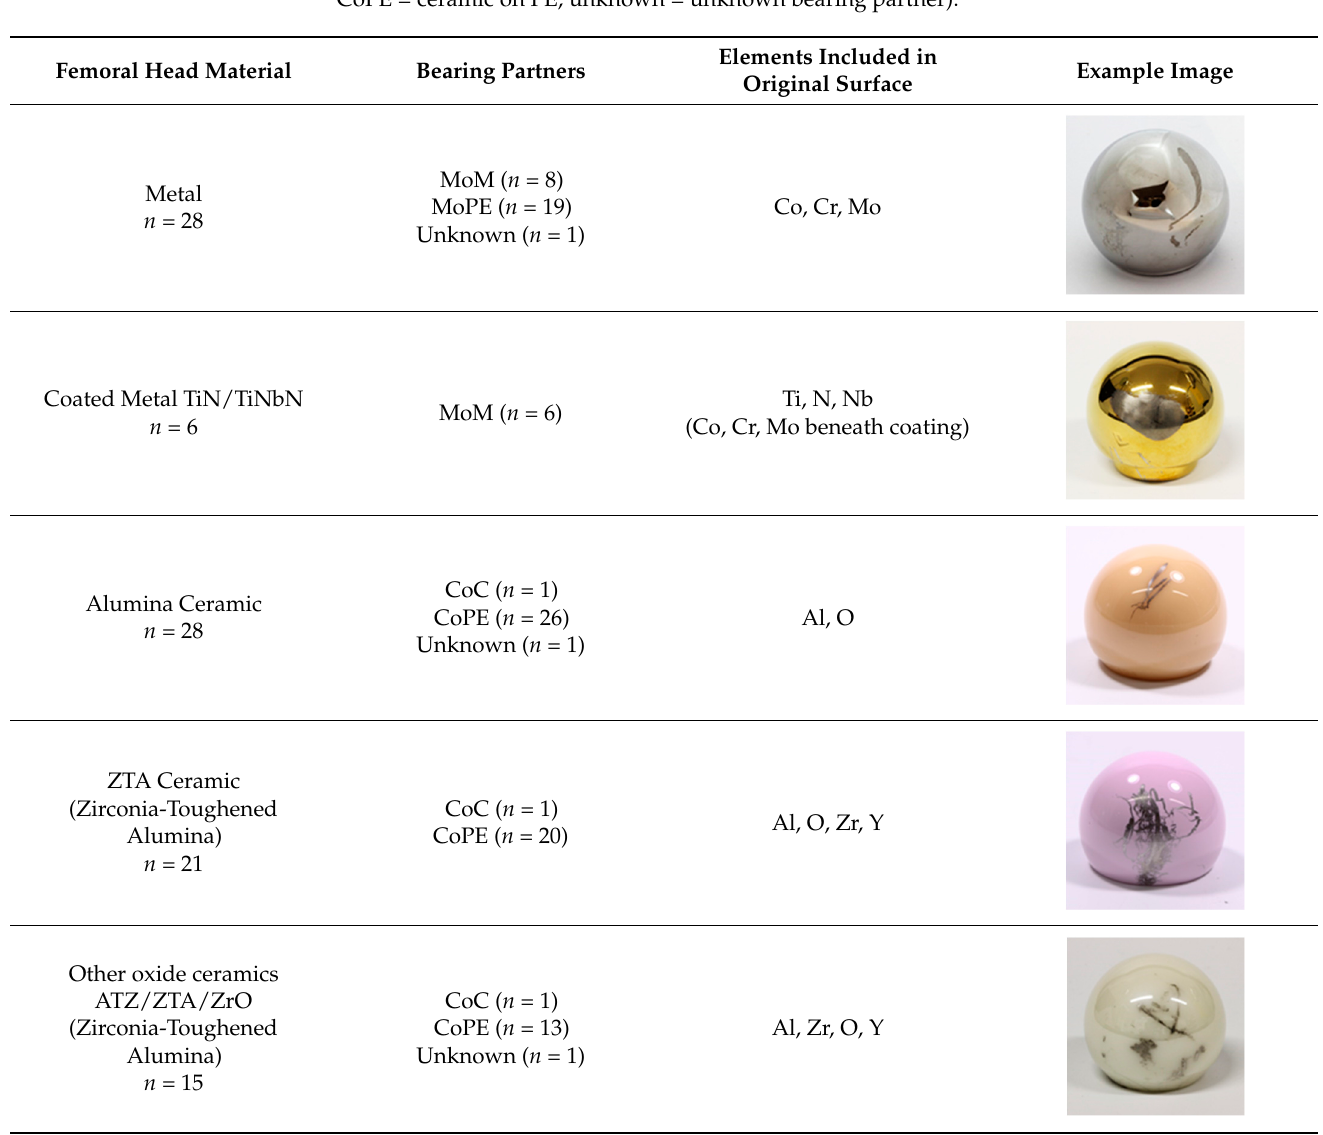
Figure 1. Workflow of the present study.